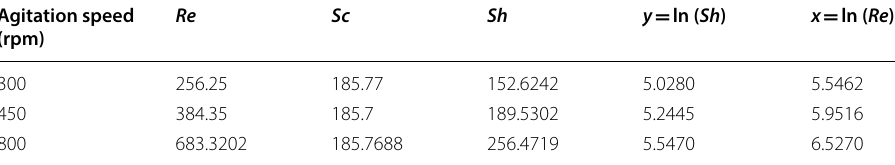
Table 5 Calculations of the values of a and b in the dimensionless correlation Agitation speed Re (rpm)